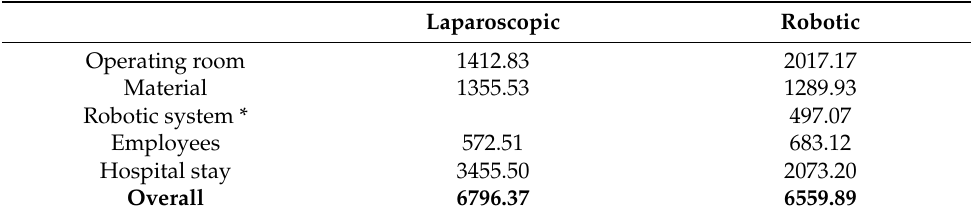
Table 5. Cost-effectiveness